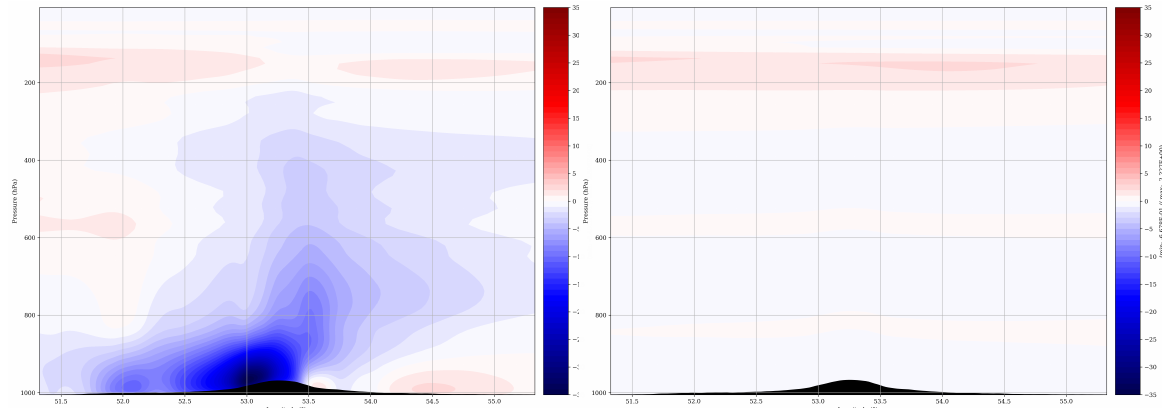
Figure 14. Zonal wind analysis increment on zonal section (51°3 E–55°3 E, 12°2 S) across TC center on 7 February 2019 02:00Z for SAR_12km_2ms ( left ) and NO_SAR ( right ). Units are m · s − 1